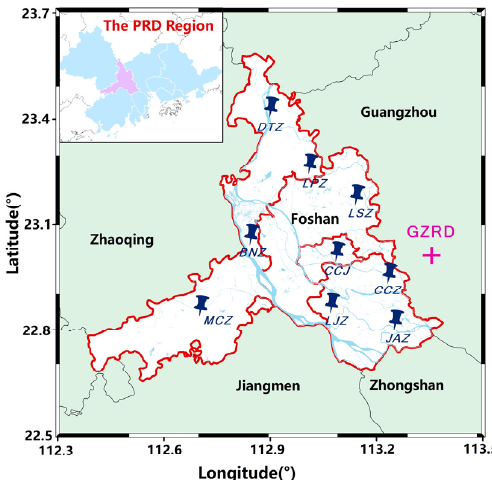
Figure 1. Geographical distribution of the FTLLS and WSR-98D. The map shows the locations of nine substations and the Guangzhou radar station. The location of the PRD region and Foshan city are shown in light blue and purple at the top left corner.